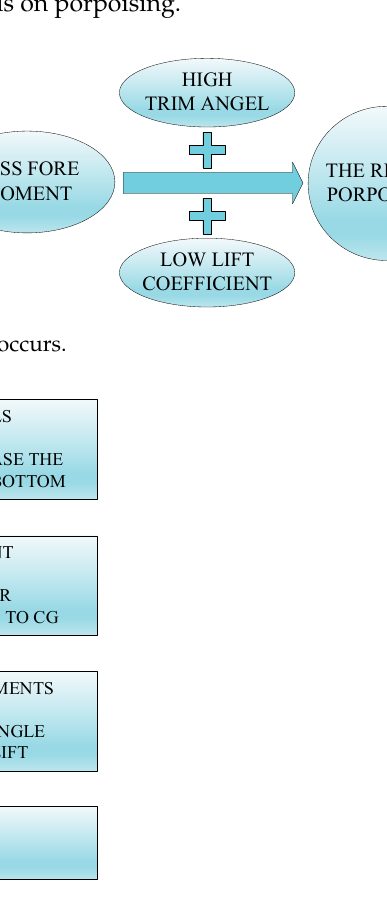
Figure 20. How side ‐ hulls inhibit porpoising. Figure 20. How side-hulls inhibit porpoising.